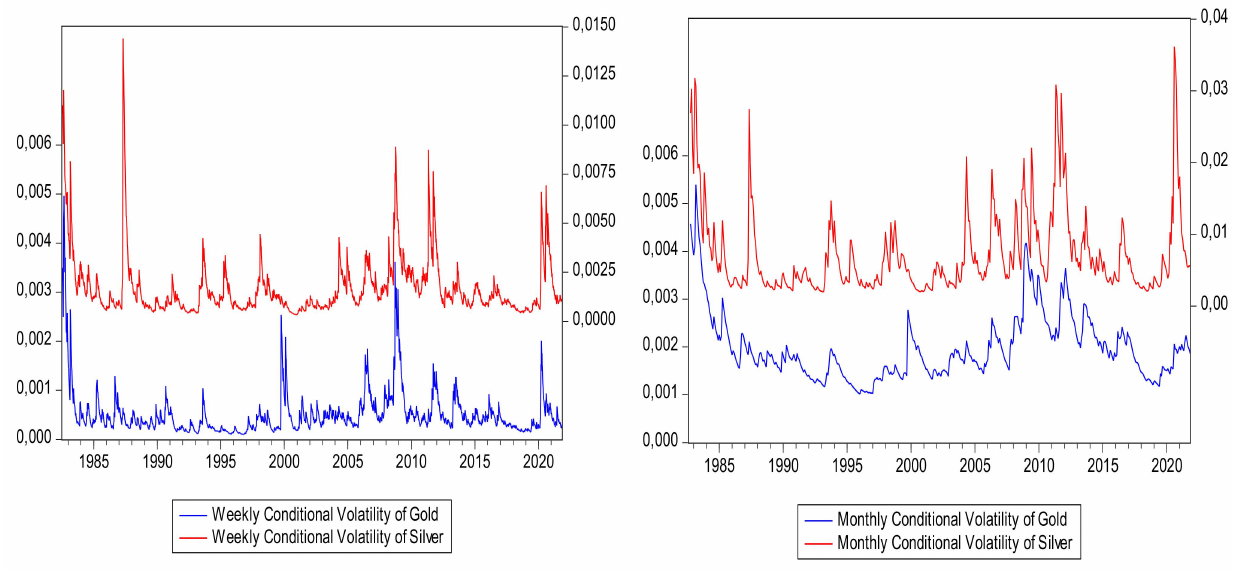
Figure 3. Gold and Silver Conditional